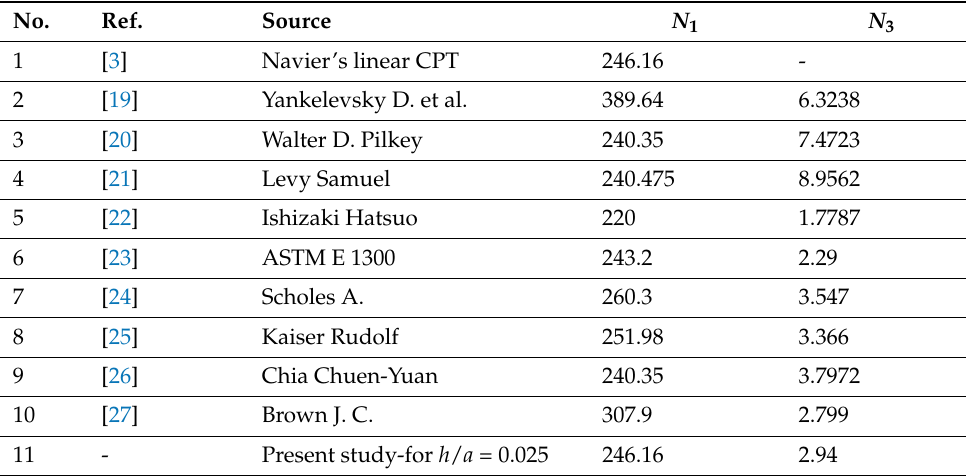
Table A1. Summary of the N 1 and N 3 coefficients found in the